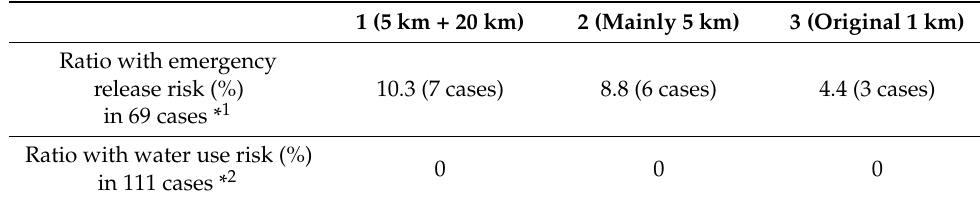
Table 1. Ratios of cases with emergency release risk or water use risk when using three different patterns of spatial resolution of rainfall forecasting. Their accuracies were assumed to be perfect. 1 (5 km + 20 km) 2 (Mainly 5